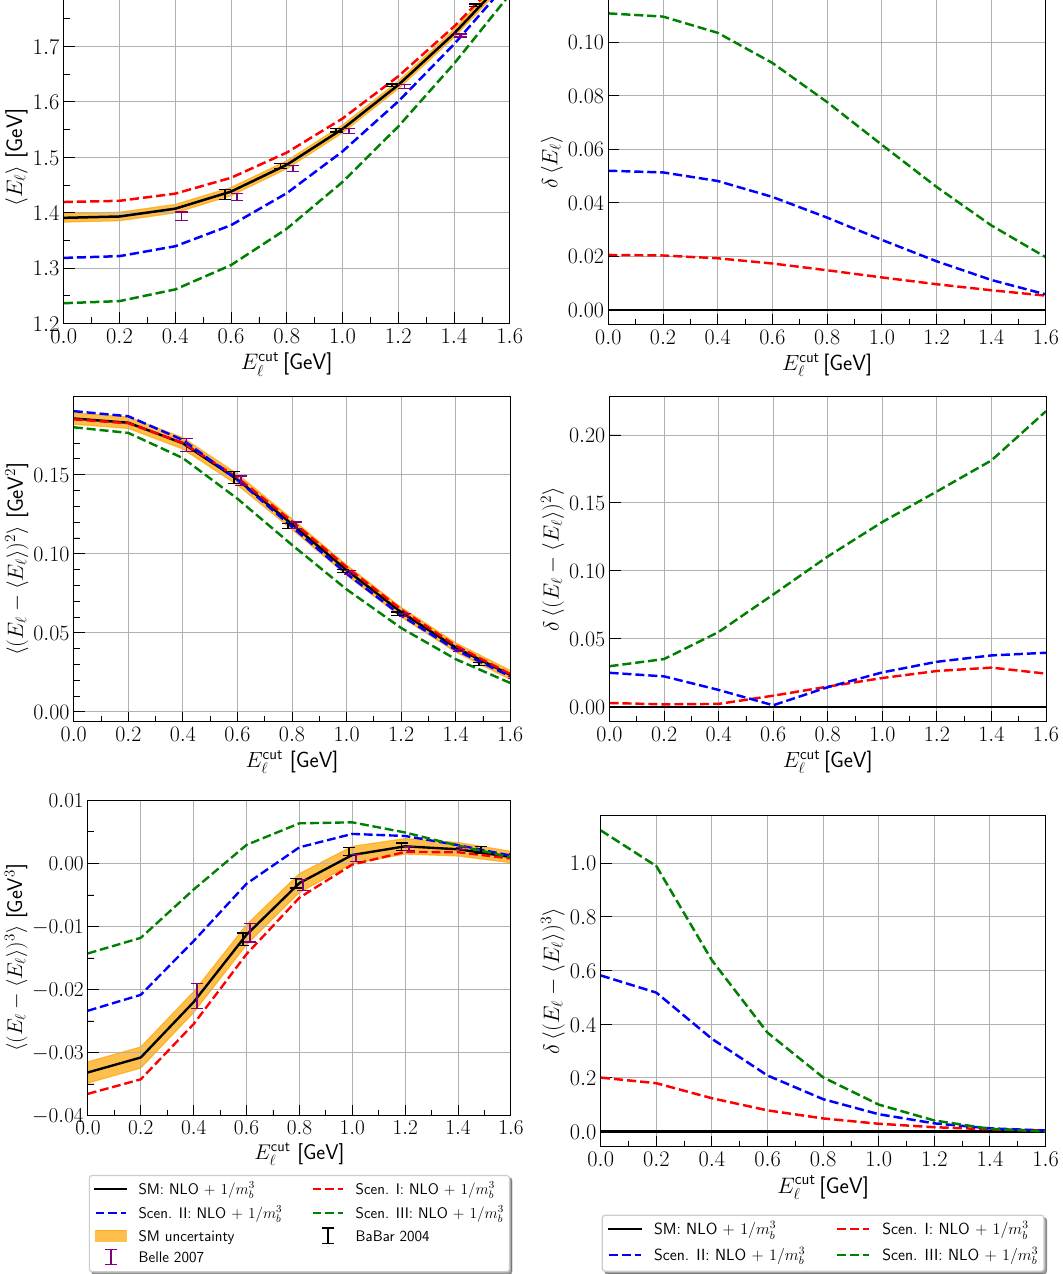
Figure 4. Lepton energy moments for the B → X c ‘ ¯ ν ‘ decay for the different NP scenarios (see table 2). The experimental results of BaBar is taken from [51] and Belle from